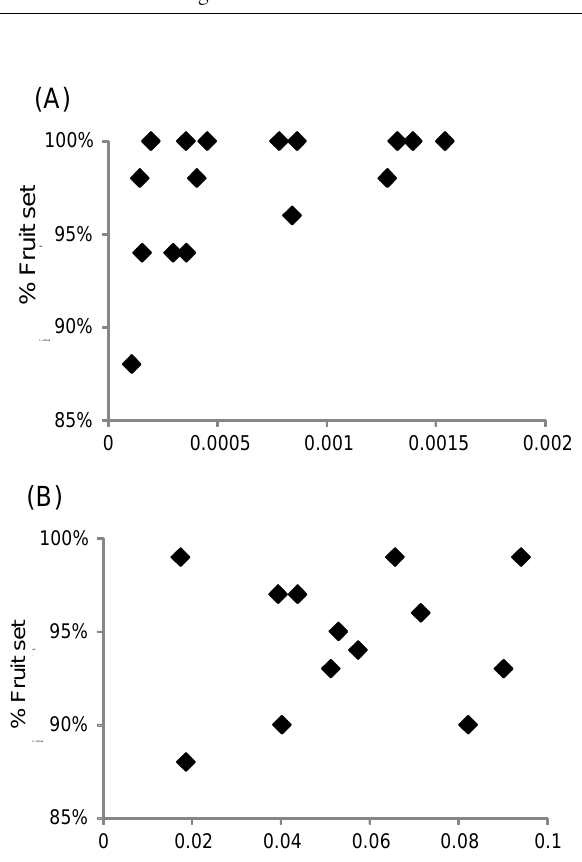
Rate of visitation (n. of pollinators F IGURE 2. Relationship between fruit-set from open- pollination and pollinators/flower/hour) in open-field tomato crops, São José de Ubá in 2010 (A) and 2012 (B).